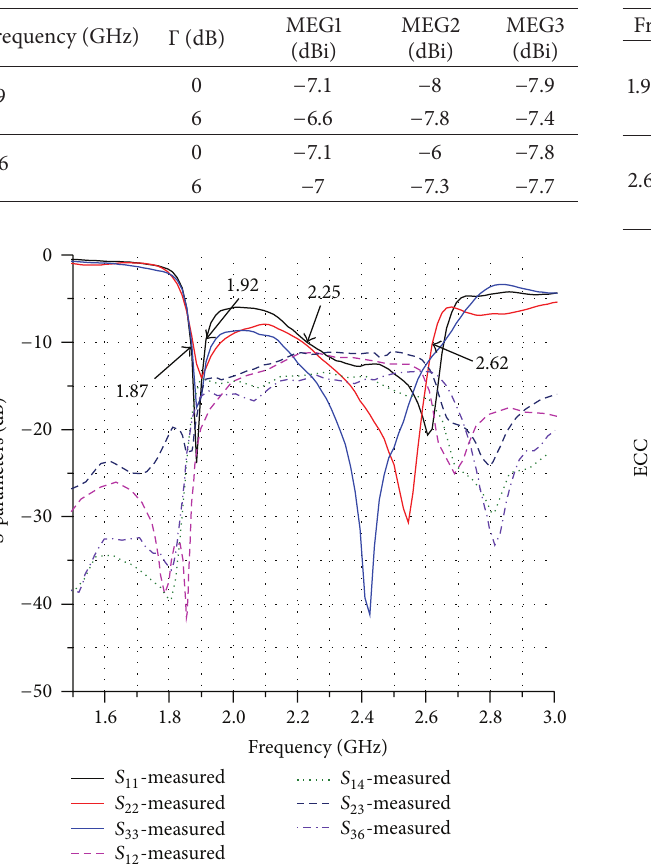
Table 5: Mean effective gains of the antennas.